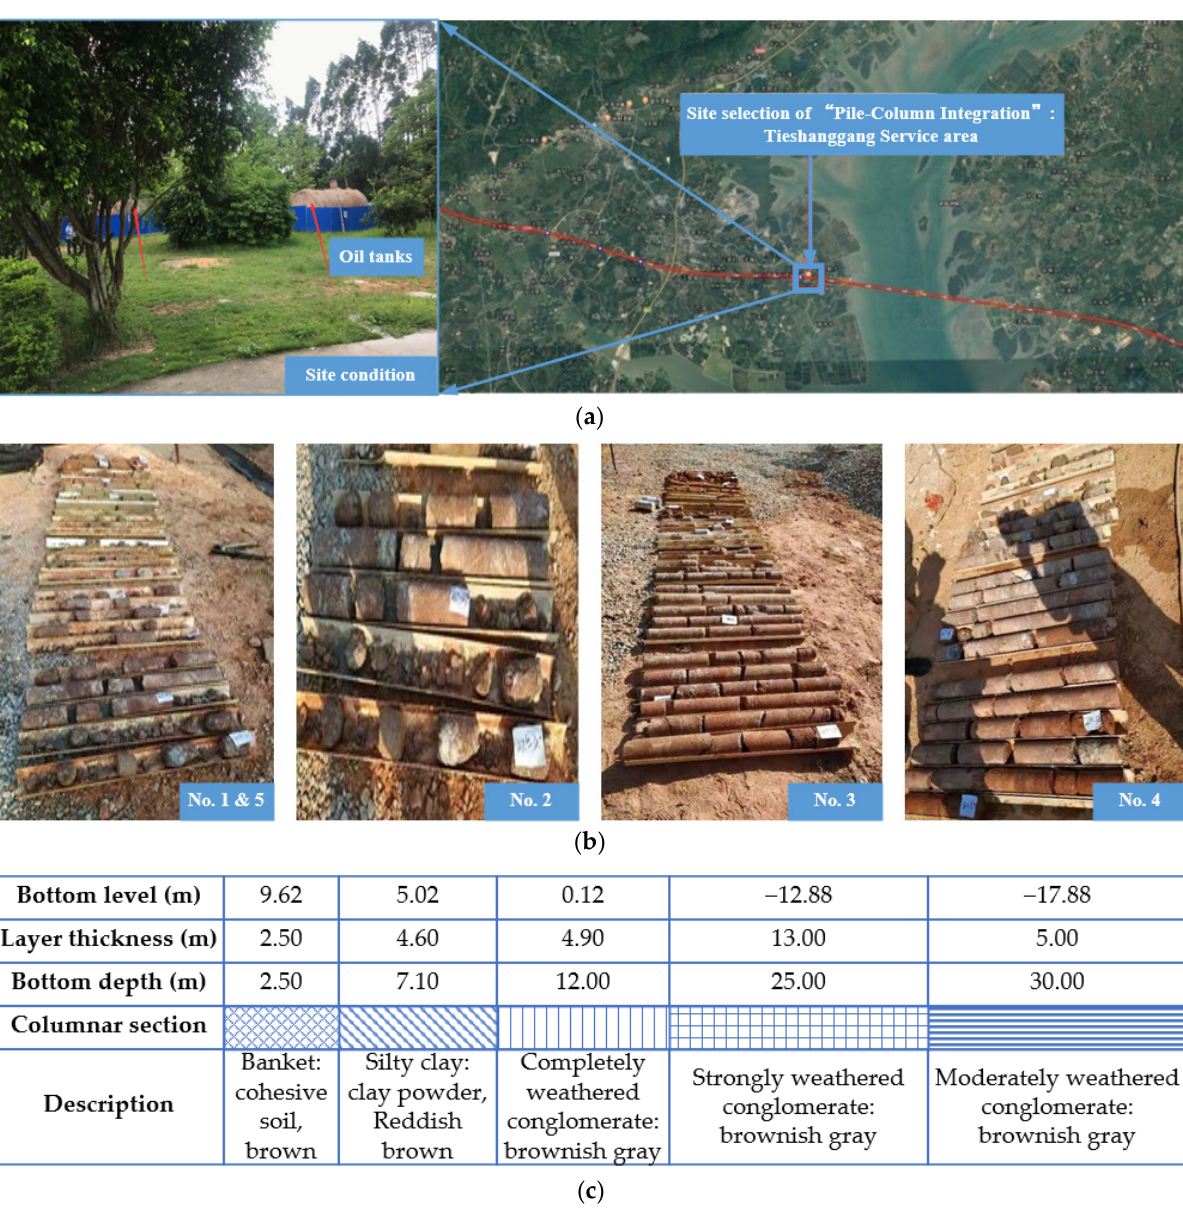
Table 1. Properties of concrete used in this study.